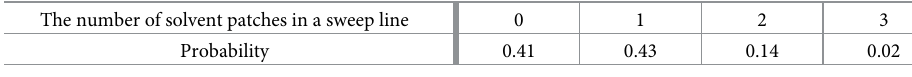
Table 2. The probability of the number of solvent patches in a sweep line. The number of solvent patches in a sweep line